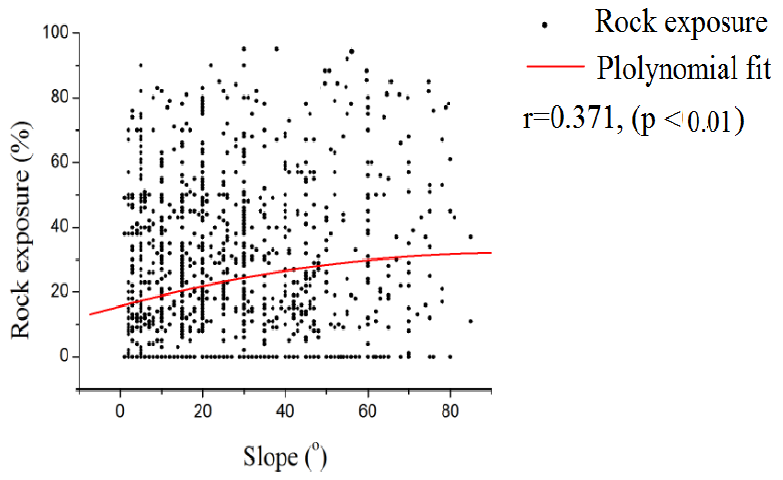
Figure 5. The relationship between slope and rock exposure